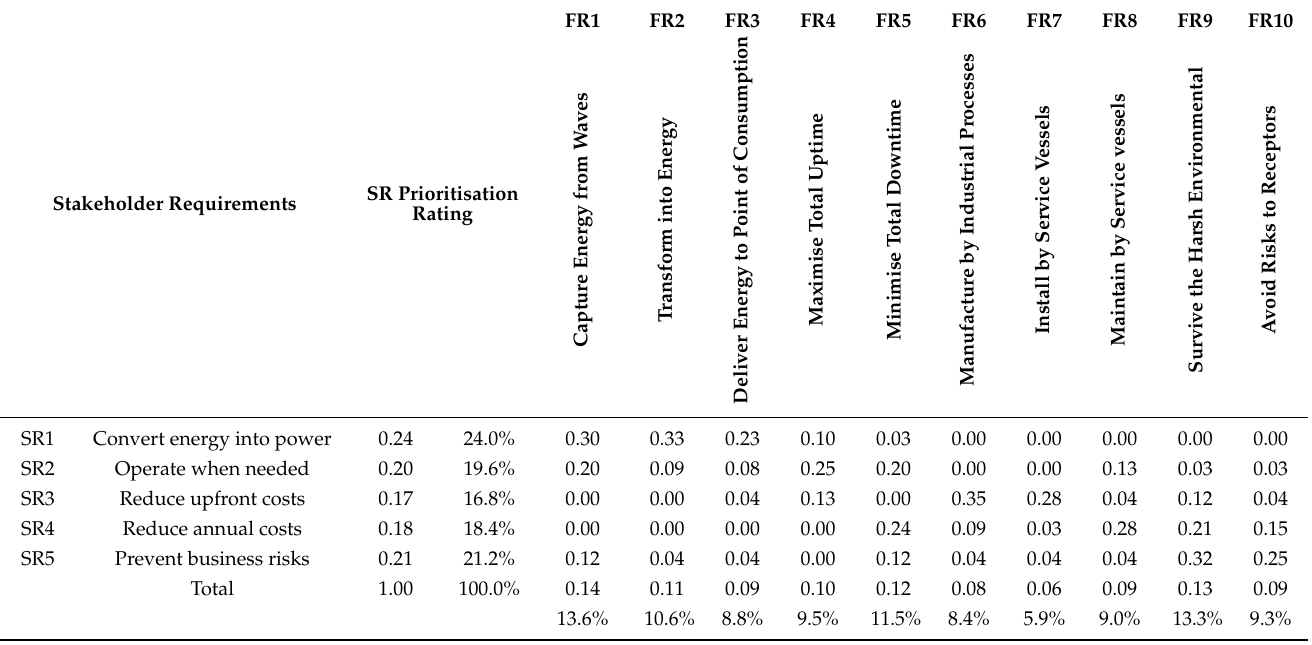
Table A6. Stakeholder Requirements (SR) to Functional Requirements (FR) for Remote community